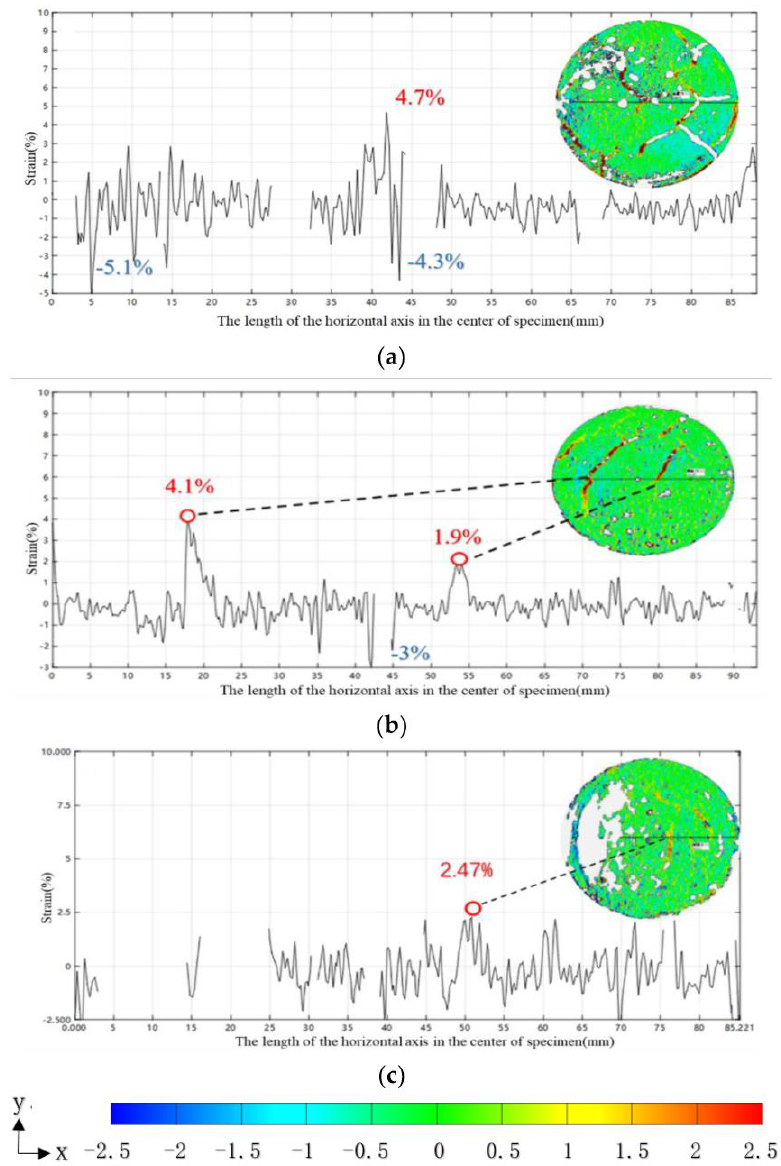
Figure 8. The strain curve along the X-direction of the horizontal axis of the specimen center at 70 min: ( a ) ε x -PC; ( b ) ε x -H0.25; ( c ) ε x